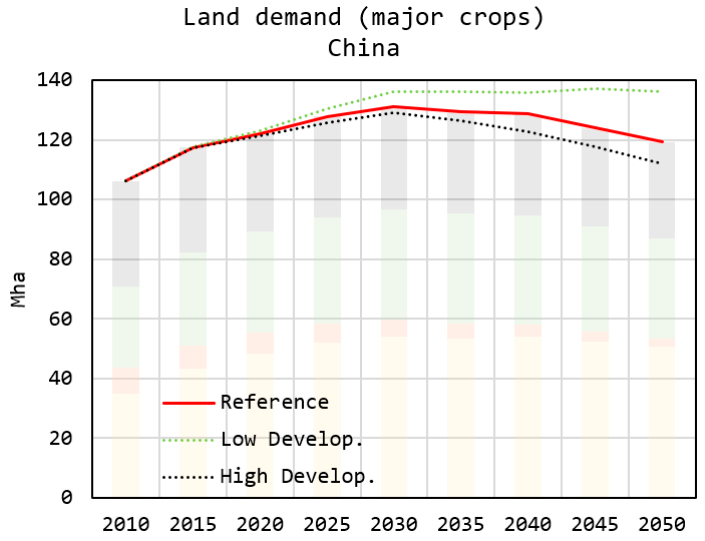
Figure 12. Land Use projections by crop for both countries for analysed scenarios.